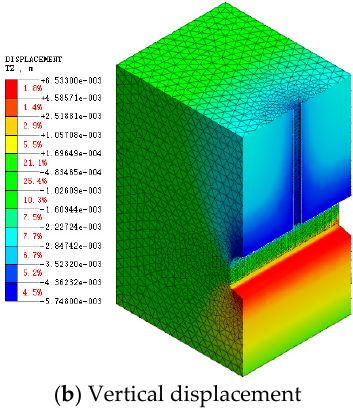
Figure 13. Displacement of surrounding rock. Figure 14 is the displacement curve of each feature point as the construction stage changed. At the same stage, the horizontal displacement at each feature point on the monitoring sections A and B was as follows: the side wall had the most displacement, the corner and the arch foot had similar degrees of deformation, and the vault had the least displacement. Due to the existence of the shaft in monitoring section C, the arch of the tunnel could not be closed into a ring, which caused the horizontal displacement of the vault to increase rapidly with the expansion and, finally, approach the horizontal displacement of the left side wall. The vertical displacement was manifested as the uplift in the corner, the settlement in the side wall, arch foot, and the vault, and the maximum settlement was in the vault. As the tunnel face approached the monitoring sections, the horizontal and vertical displacement of the surrounding rock gradually increased. When the tunnel face reached monitoring sections, due to the unloading effect of the rock mass, the vertical displacement rate increased rapidly and then stabilized as the tunnel face progressed further. Compared with section A, the maximum horizontal displacement of section C increased by 47.5%, the vault settlement increased by 29.3%, and the existence of a ventilation shaft weakened the stability of surrounding rock during the expansion process.